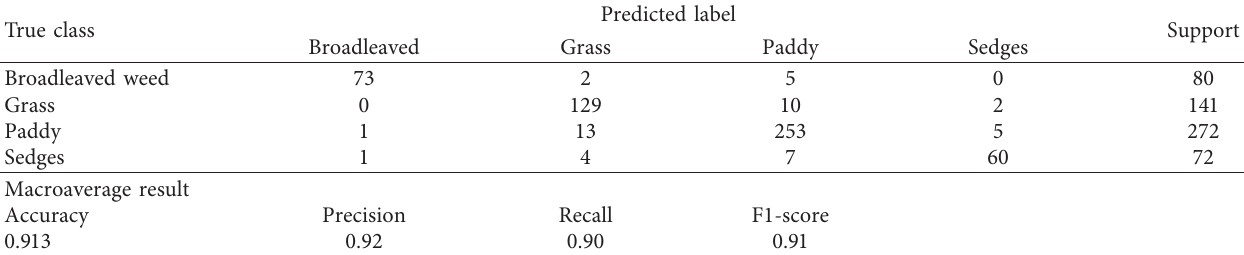
Figure 11: Kappa statistic. Table 6: Classification result of MCS-1.